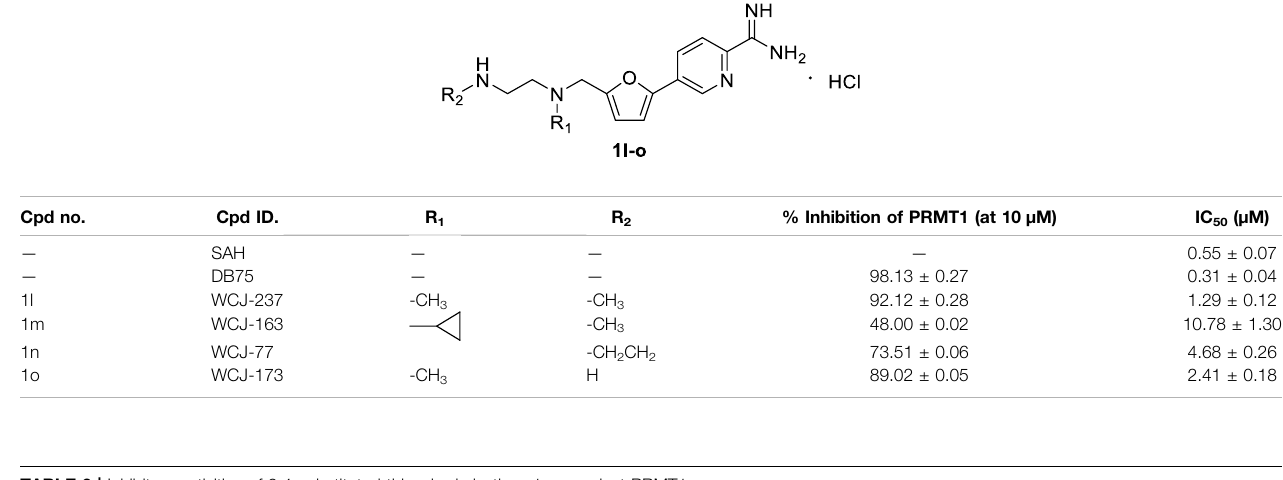
TABLE 2 | Inhibitory activities of 2,5-substituted furan derivatives 1l – o against PRMT1.